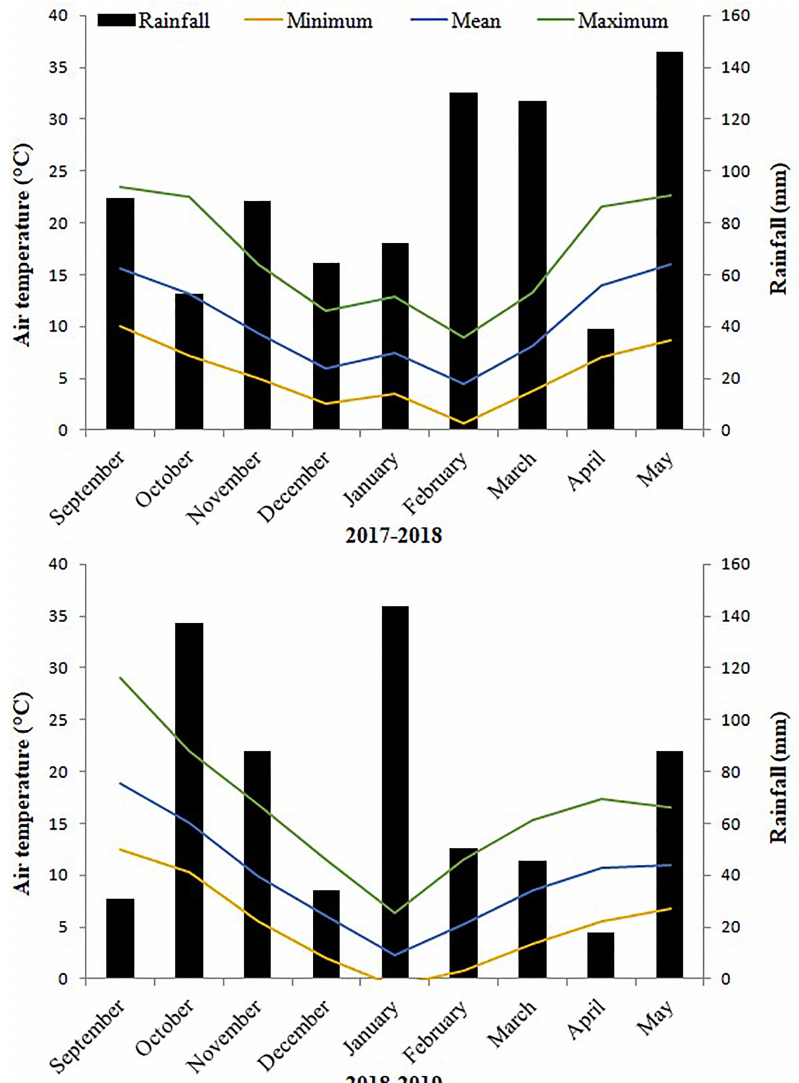
Figure 1. Monthly minimum, mean and maximum air temperatures and total rainfall recorded during the two growing seasons (2017–2018 and 2018–2019) in